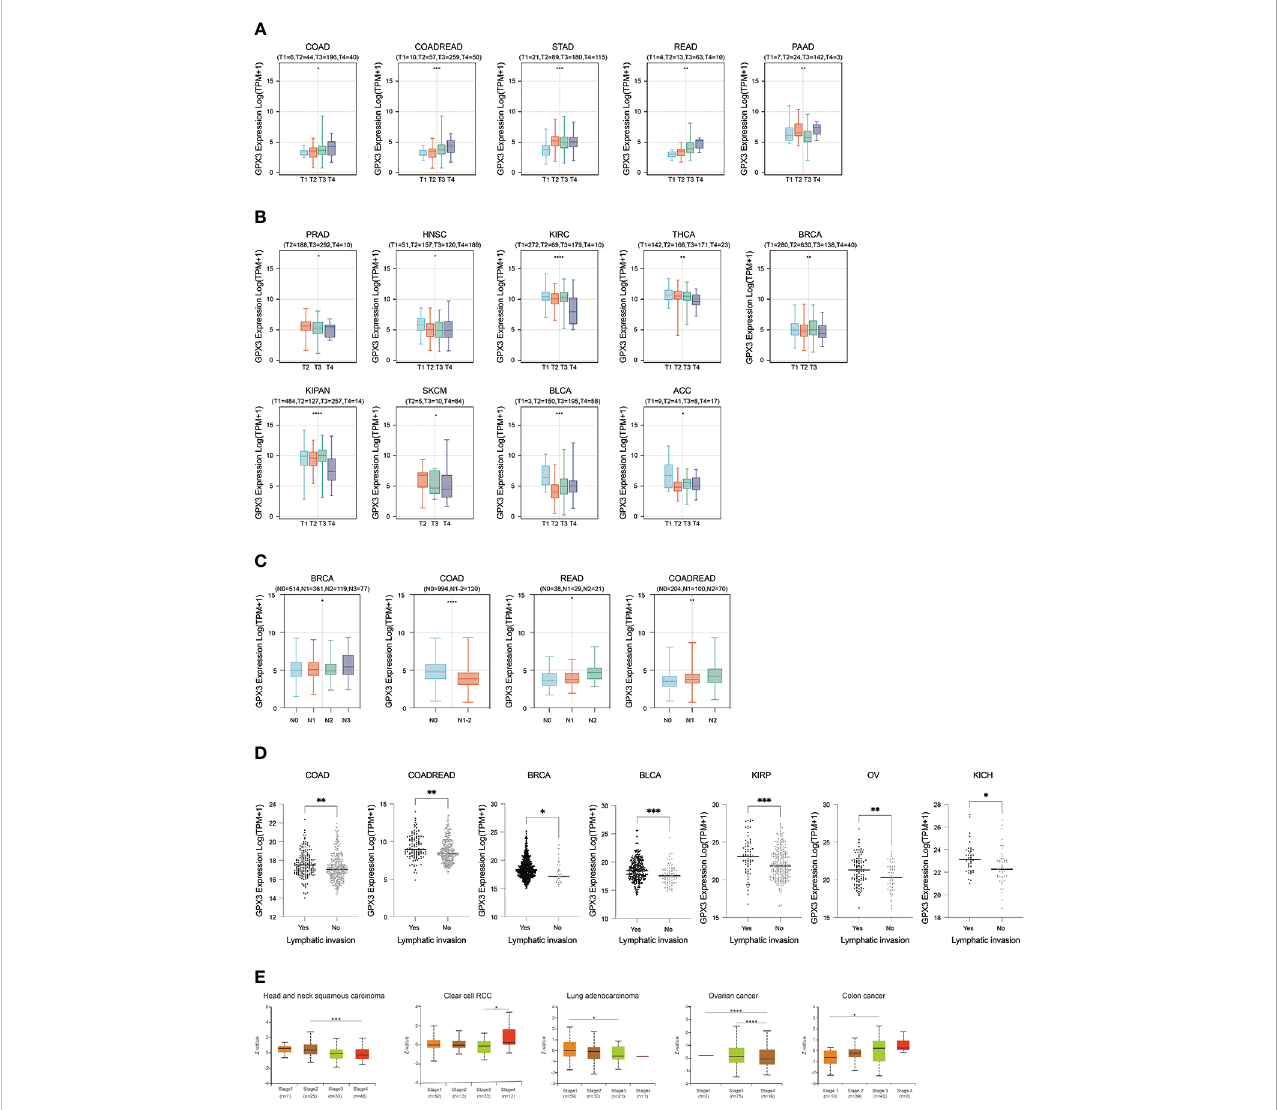
FIGURE 2 The expression of GPX3 was correlated with stage and lymph node metastases. (A) The GPX3 expression was positively correlated with T stage in COAD, READ, STAD, and PAAD. (B) The GPX3 expression was negatively correlated with T stage in PRAD, HNSC, KIRC, BRCA, KIPA, SKCM, BLCA, and ACC. (C) High GPX3 expression was associated with higher N stage in COAD, READ, BRCA, BLCA, KIRP, OV and KICH. (D) High GPX3 expression was associated with lymph node metastases in COAD, READ, BRCA, BLCA, KIRP, OV and KICH. (E) GPX3 protein expression was correlated with the pathological stages of HNSC, ccRcc, LUAD, OV, and COAD in CPTAC